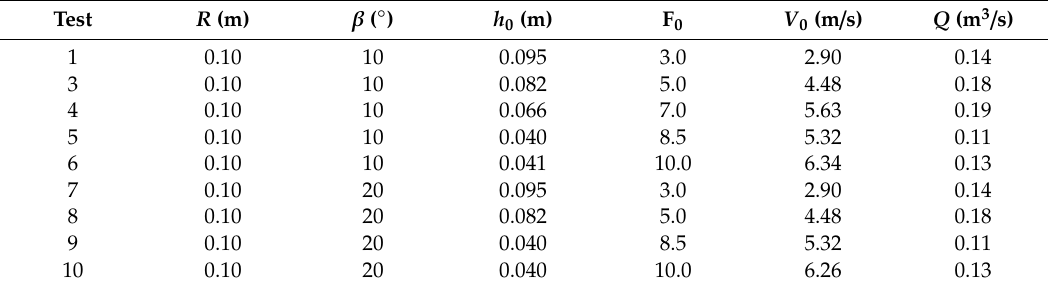
Table 1. Characteristic parameters of numerical